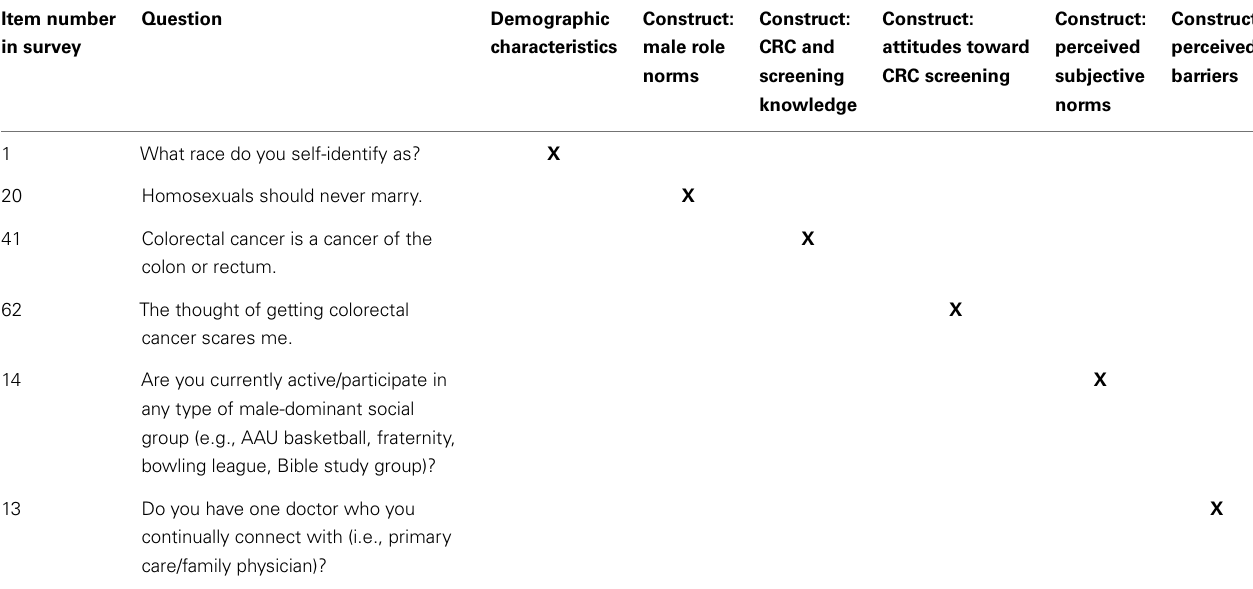
Table 1 | Samples of items used in the survey ofAfricanAmerican young adult men, to assess their male role norms, knowledge, attitudes, and perceptions of CRCS